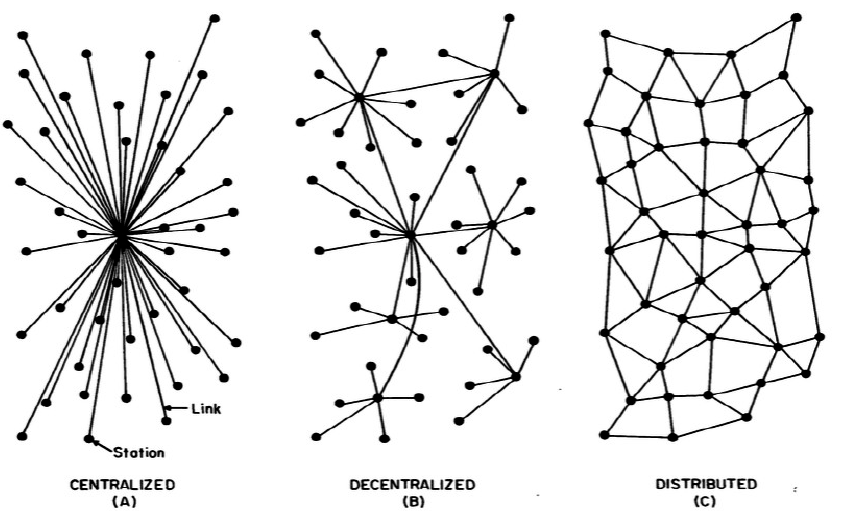
Figure 1. Centralized vs. Decentralized vs. Distributed